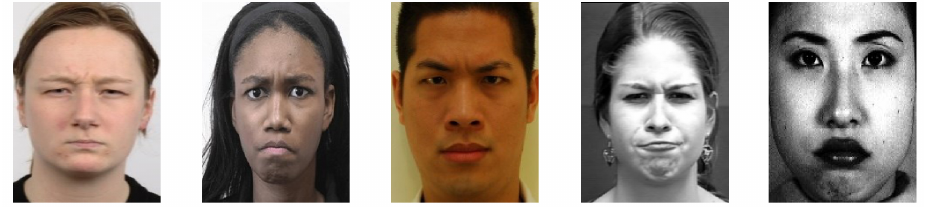
Figure 1. Facial expression representation variations from Moroccans, Caucasians to Taiwanese, Americans, and Japanese